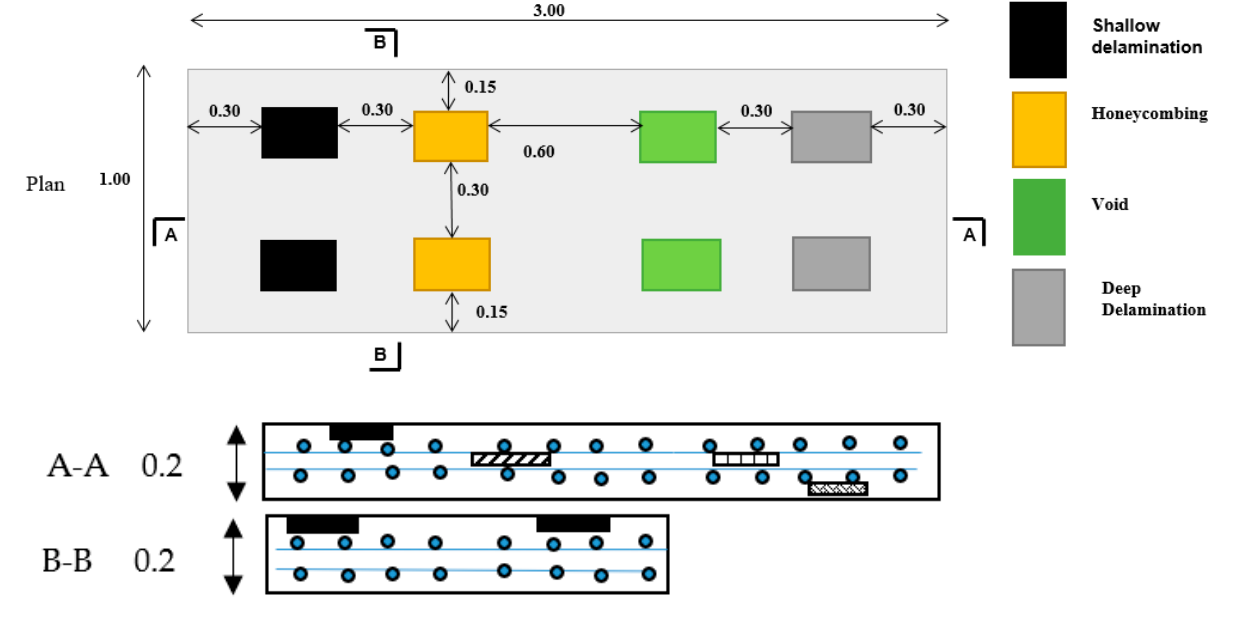
Figure 1. Details of the slabs.